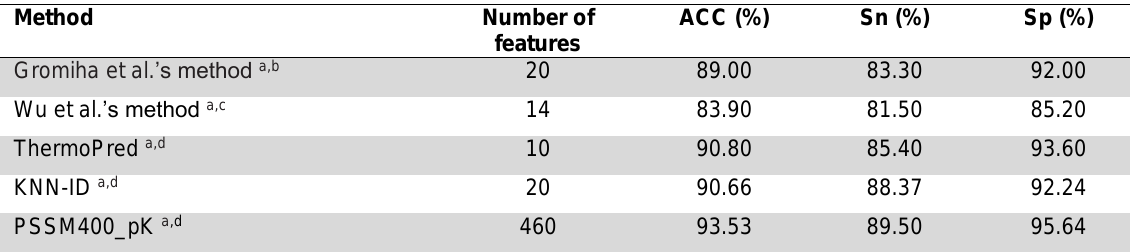
Table 3: Performance comparison of Gromiha et al.’s method, Wu et al.’s method, ThermoPred, KNN- ID, PSSM400_pK on the Gromiha2007 dataset